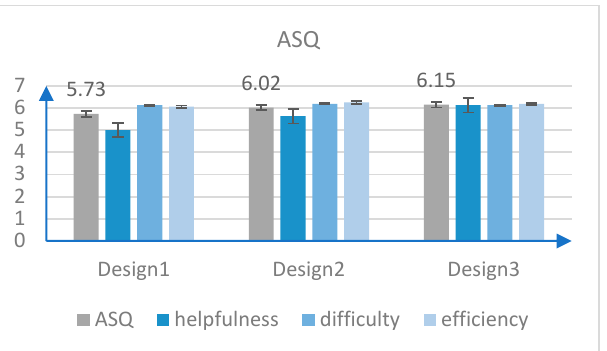
Figure 7. Scores from the SAGAT questionnaire. The first column of each design is the SAGAT score, and the next three columns are its three-dimensional scores.